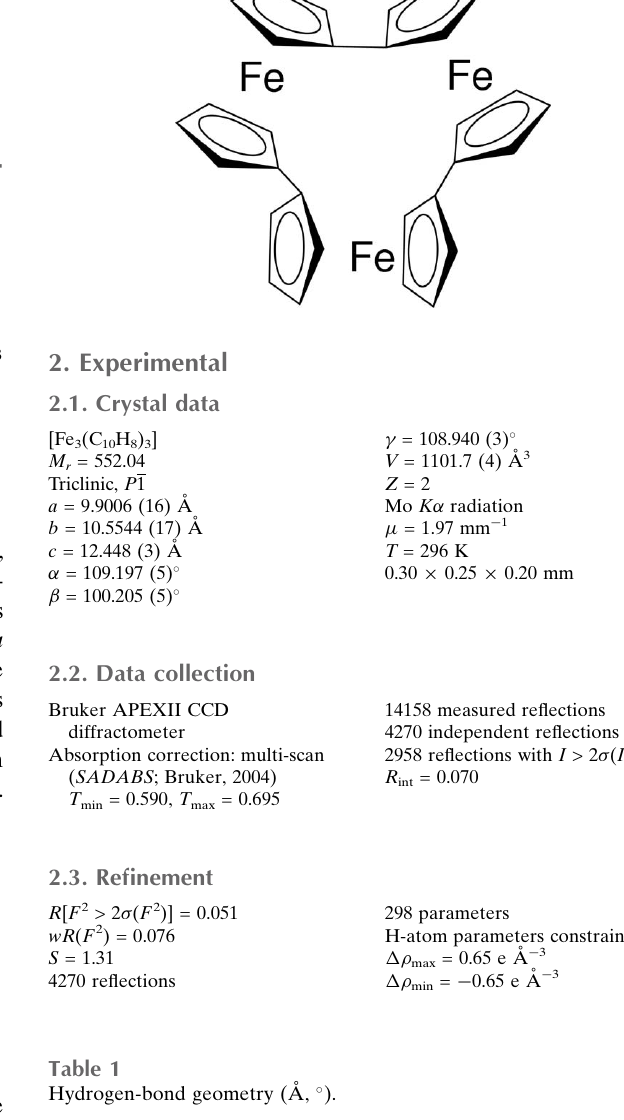
Hydrogen-bond geometry (A˚ , (cid:2)